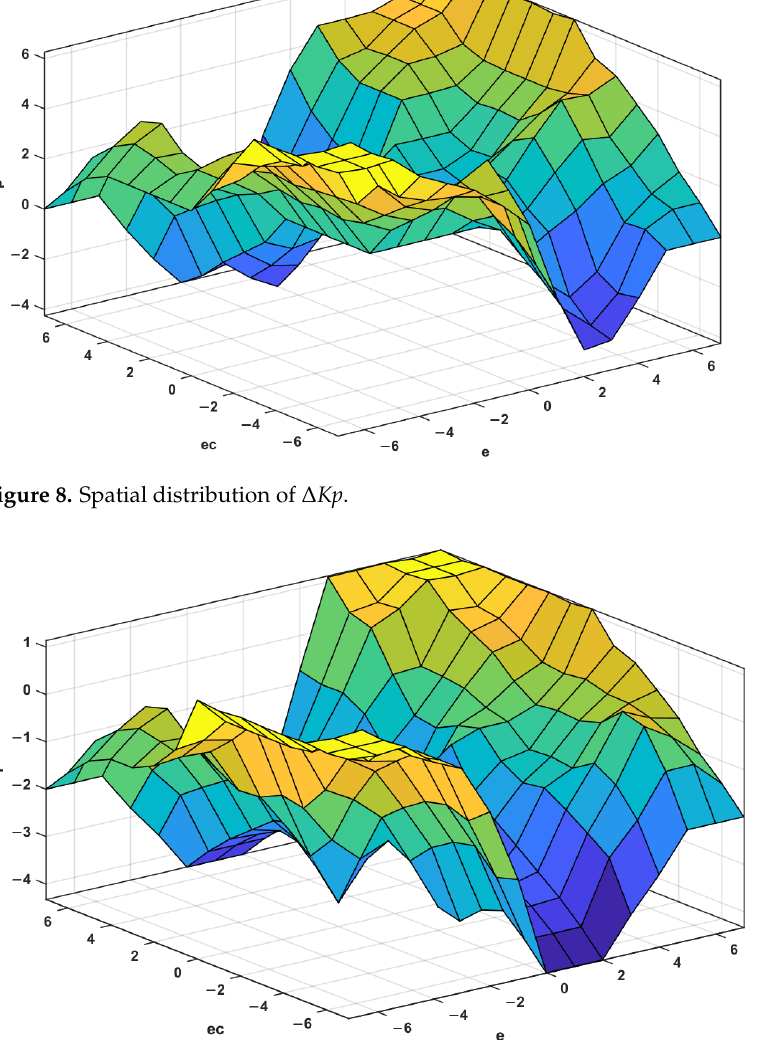
Figure 8. Spatial distribution of △ Kp. Table 2. △ K p fuzzy inference rule table.